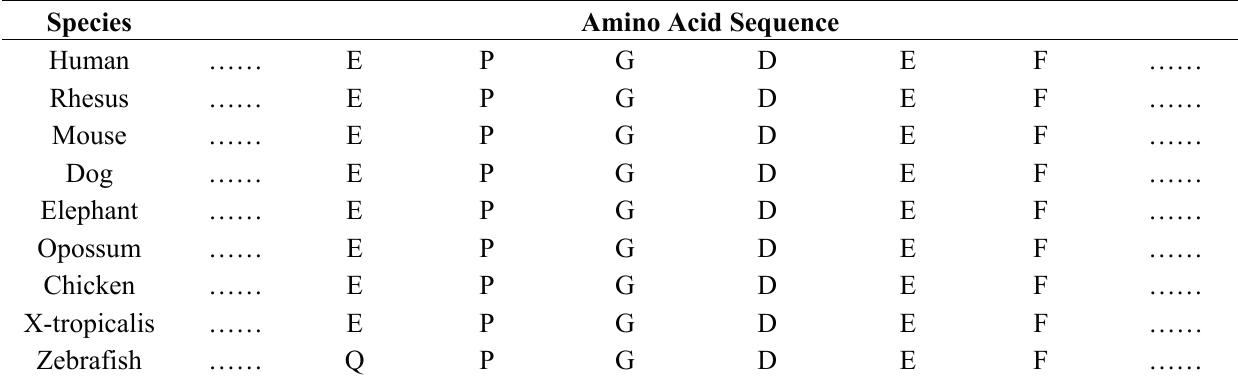
conserved p.289 glycine from fish to